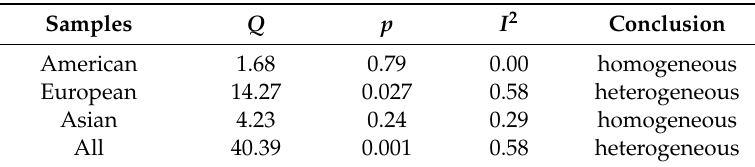
Table 2. Results of tests for homogeneity of the OR.